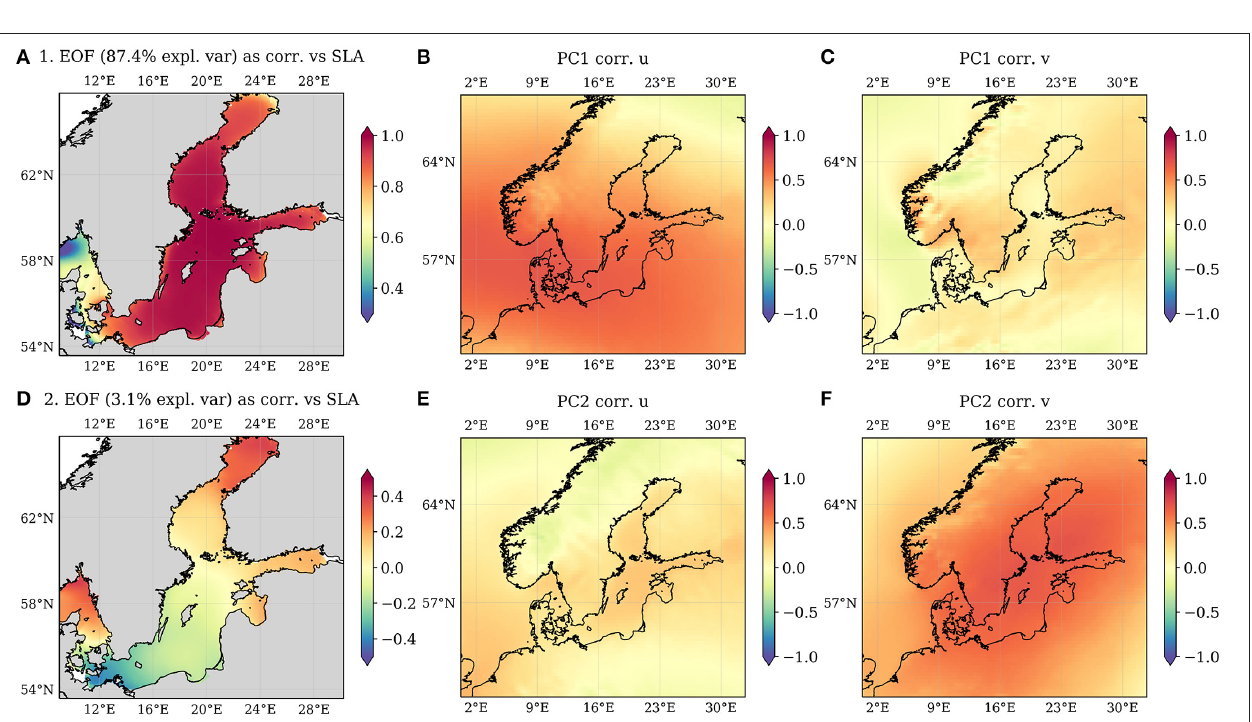
FIGURE 9 | (A,D) Empirical orthogonal functions of SL variability expressed as correlation of their corresponding PC against the SL time series at each grid point. (B,C) Correlation between the first PC of SL variability and the zonal (U) and meridional (V) component of the surface winds. (E,F) Same for the second PC.